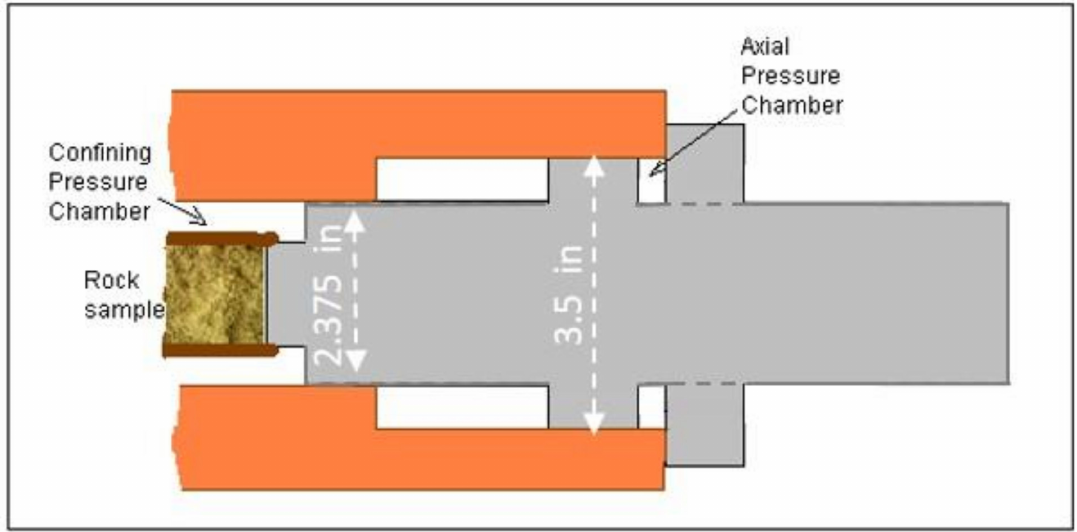
Figure 4. Dimensions of the axial loading chamber in the frac-n-flow